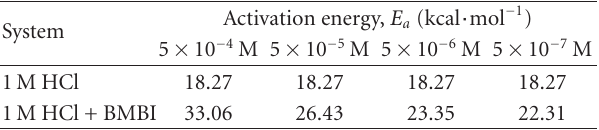
Figure 6: E ff ect of concentration of 3-Benzoylmethyl benzimi- dazolium hexafluoroantimonate (BMBI) triphenyl phosphonium bromide on the percent inhibition of mild steel in 1.0 M HCl at various temperatures. Table 4: The activation energy ( E a ) for the corrosion of mild steel in 1.0M HCl with and without 3-benzoylmethyl benzimidazolium hexafluoroantimonate inhibitor at various concentrations.